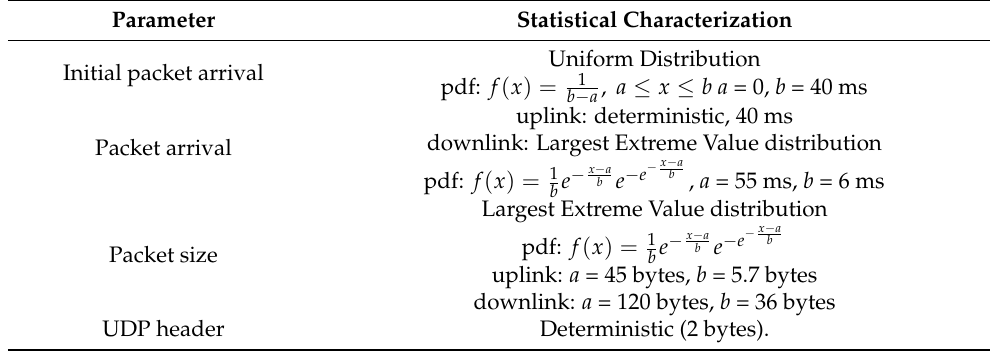
Table A5. Online gaming traffic